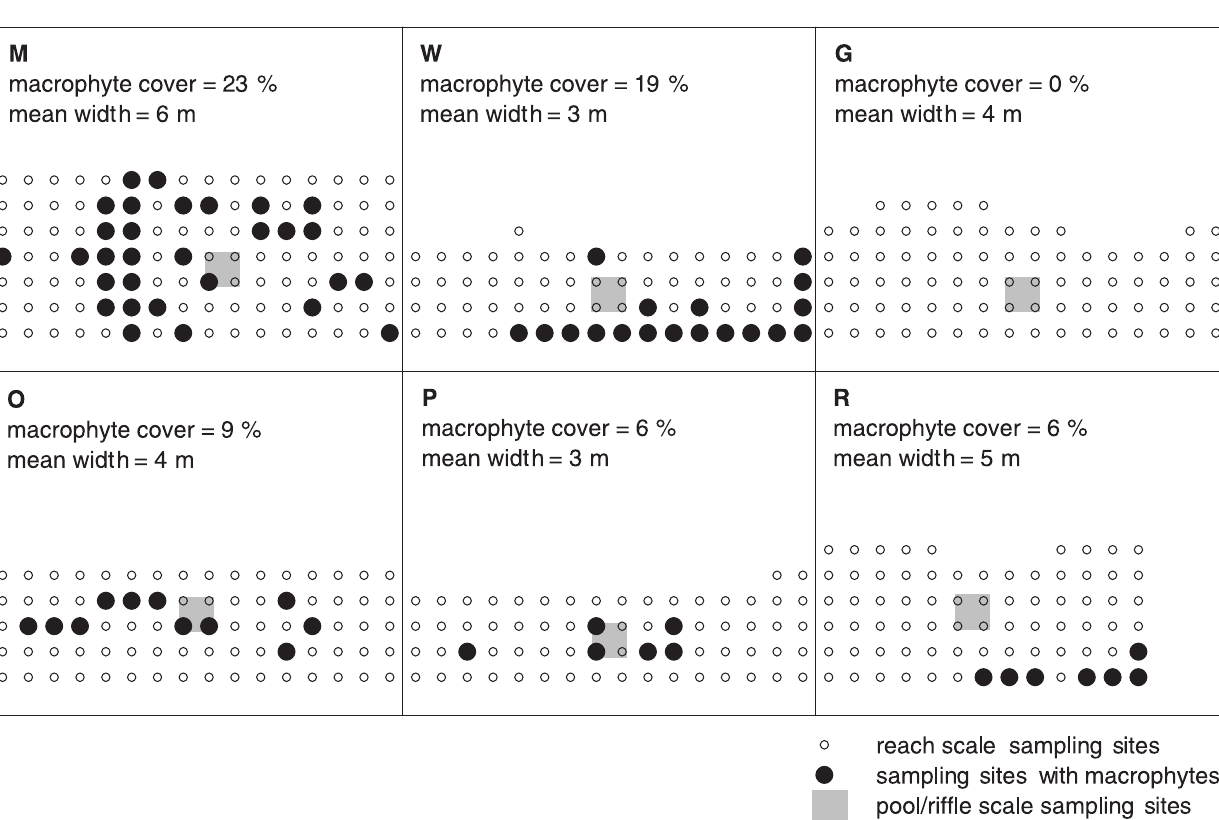
Figure 2. Detailed sampling design and macrophyte cover. The adjusted sampling designs according to stream widths (circles at 1 m distance represent sampling sites of the reach scale grid). Solid circles indicate sampling sites with submerged macrophytes, open circles indicate sampling sites without submerged macrophytes. The area of the pool/riffle scale grid is denoted in grey (the 49 sampling sites of the pool/riffle scale grid are not explicitly shown here, but see Fig. 1). The stream reaches are M = Moosach, W = Wiesent, G = Guenz, O = Grosse Ohe, P = Perlenbach, R = Suedliche Regnitz.